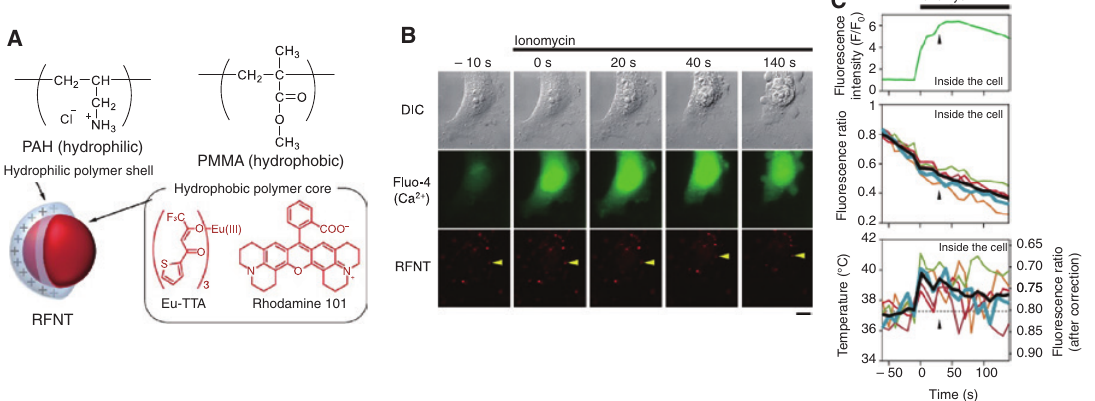
Figure 13: Intracellular thermometry of living HeLa cells using a ratiometric fluorescent nanothermometer (RFNT) containing Eu-TTA and rhodamine 101. (A) Structure of the RFNT. The hydrophilic shell and hydrophobic core were composed of PAH and poly(methyl methacrylate) (PMMA), respec- tively. (B) Time lapse imaging of DIC, Fluo-4 (indicating Ca 2 + ion), and rhodamine 101 in the RFNT after application of the ionomycin-Ca 2 + complex. (C) Time courses of the fluorescence intensity of Fluo-4 (top), the fluorescence intensity ratio (Eu-TTA/rhodamine 101) of the RFNT (middle), and the evaluated temperature using the fluorescence ratio corrected by cancelling the photobleaching effects. Reproduced with permission from Takei et al. (2014). Copyright 2014 American Chemical Society.